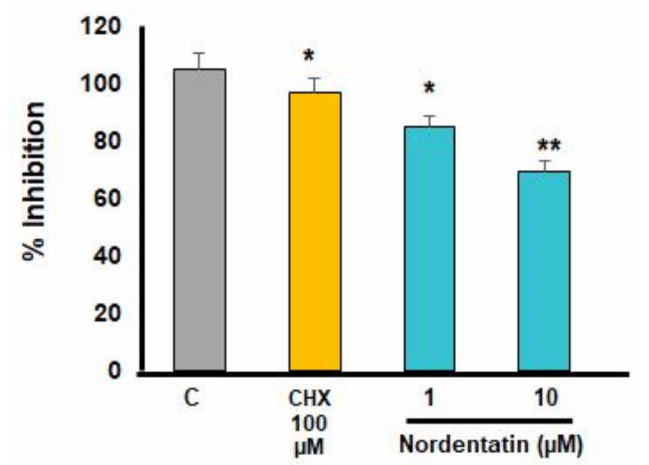
Figure 3. A transwell migration assay was used to investigate the inhibition of neuroblastoma cells (SH-SY5Y).